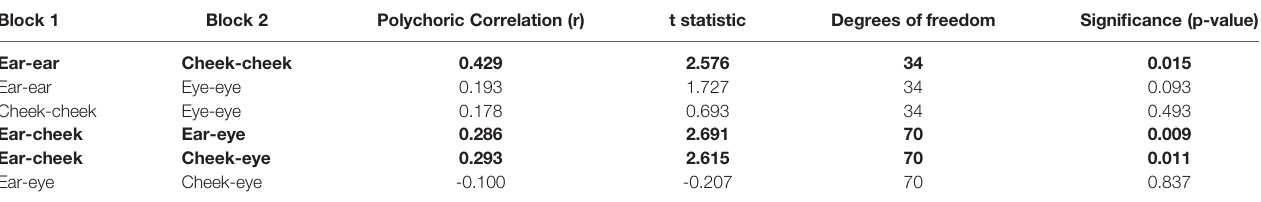
TABLE 5 | MTMM Heterotrait Inter-block Correlations (bold = p<